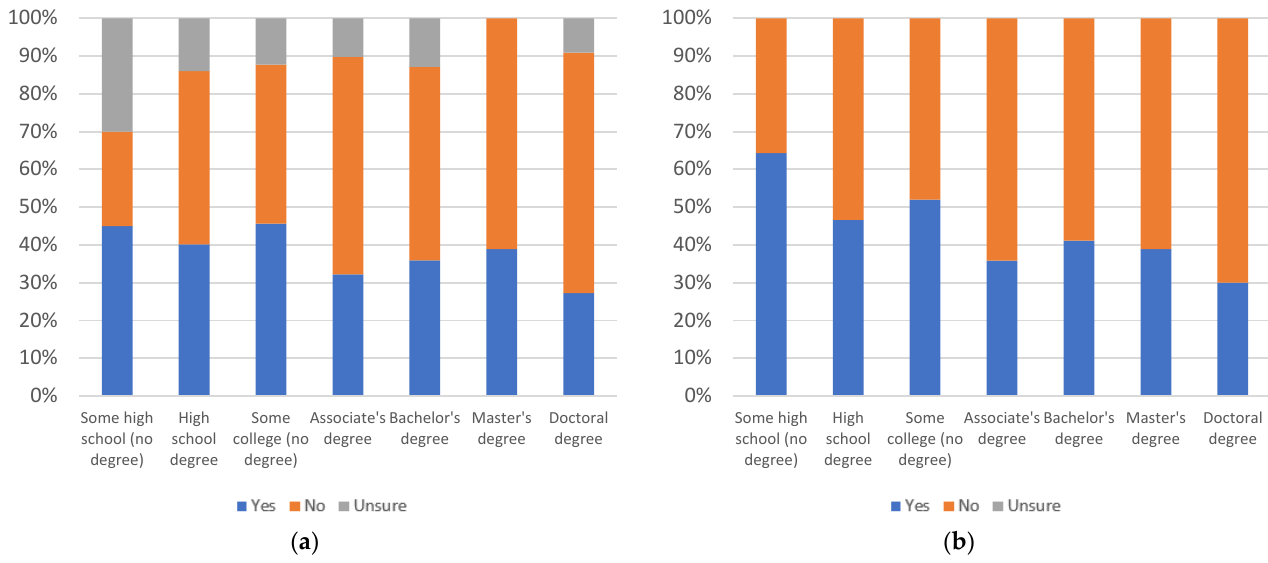
Figure 105. Label annoyingness, by education level: ( a ) with uncertain respondents (left) and ( b ) without uncertain respondents (right).